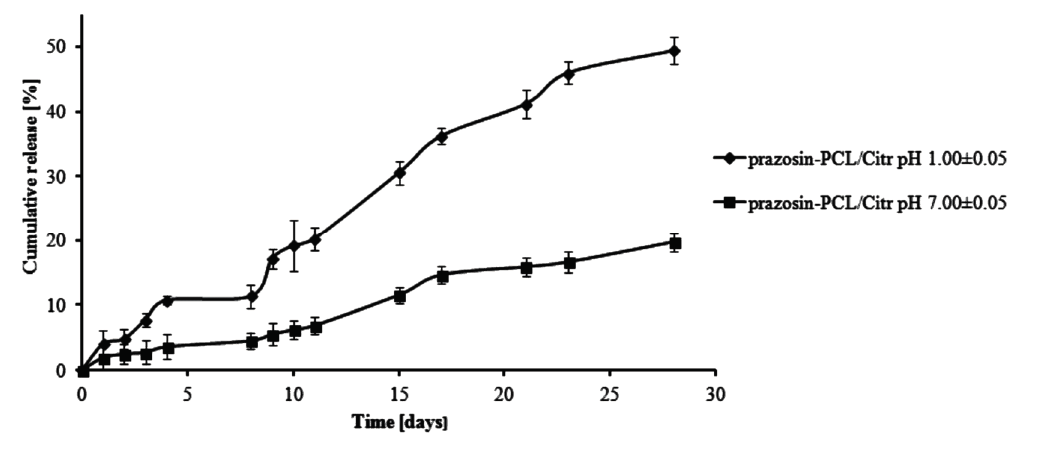
Figure 4. Release profile of prazosin from the prazosin–PCL/Citr conjugate (pH 7.00 ± 0.05 and pH 1.00 ±